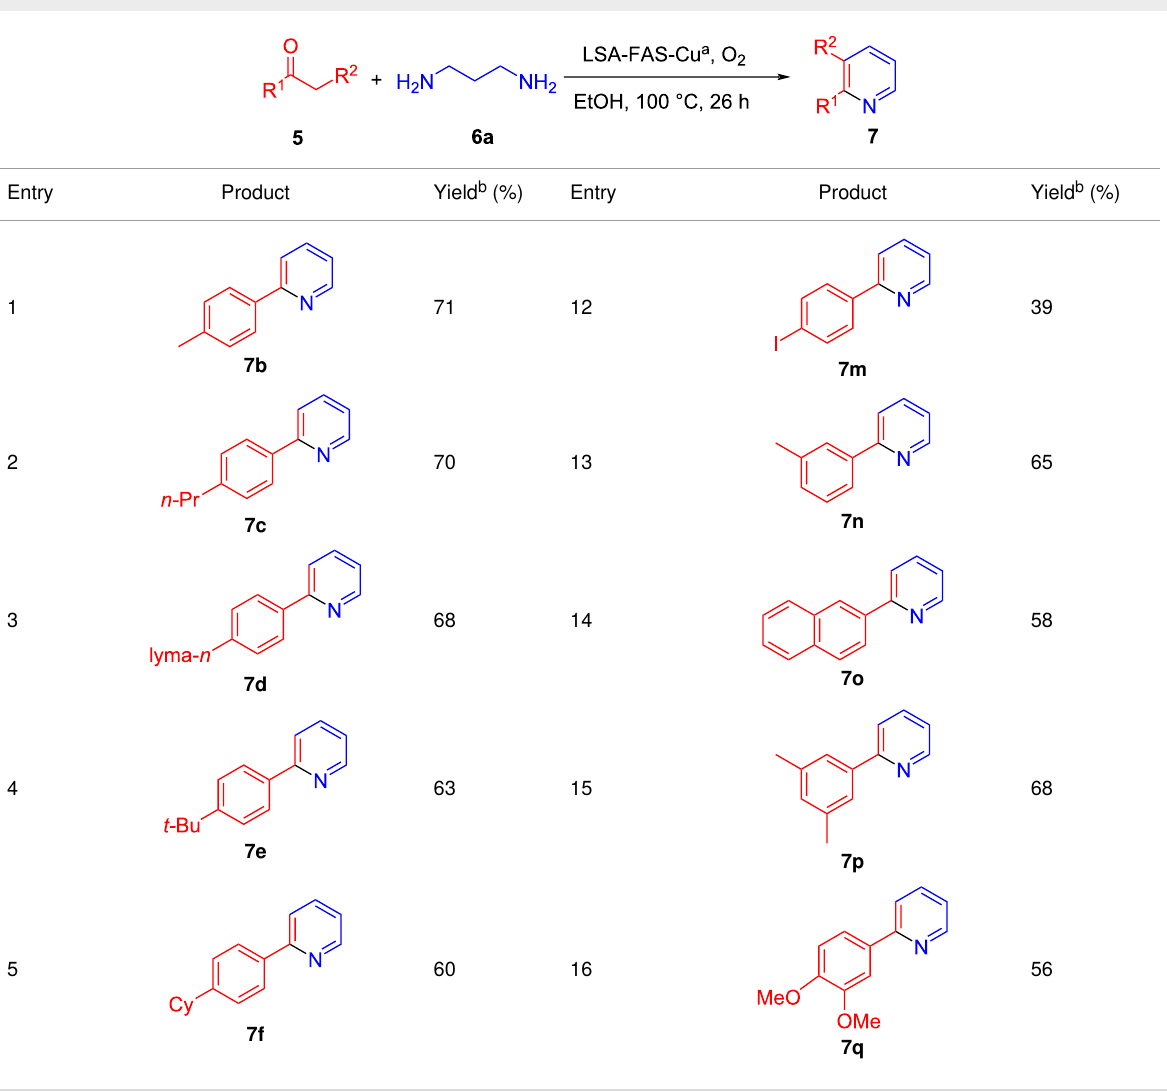
Table 4: Substrate scope of the ketones catalyzed by LSA-FAS-Cu.